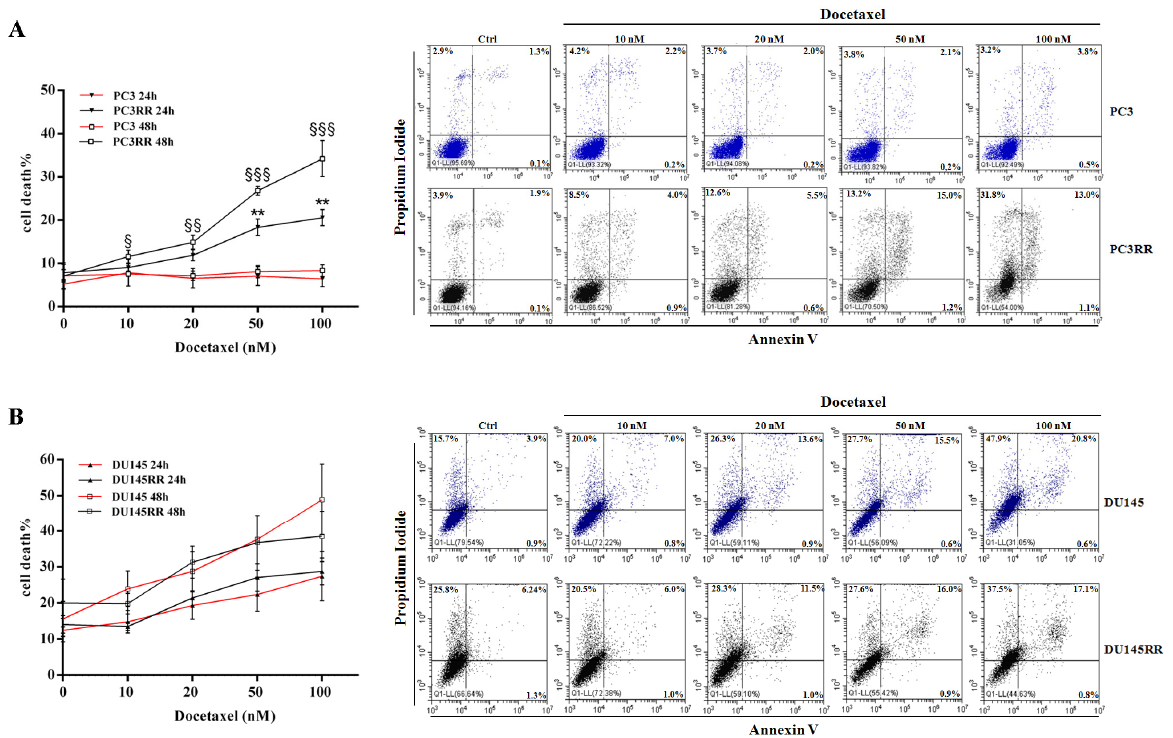
Figure 11. Effect of Docetaxel treatment on the viability of PC3/PC3RR cells and DU-145/DU-145RR cells.( A ) Representative dot plot of flow cytometry analysis for Annexin-V/Propidium Iodide staining in PC3/PC3RR (( A ), right) and DU-145/DU-145RR cells (( B ), right) to evaluate percentage of dead cells after treatment with different concentrations of Docetaxel at 48 h. For each dot plot, necrotic cells are localised in the upper left panel, whereas late and early apoptotic cells are in the upper and down right panels, respectively. The graphs show the percentage of cell death at 24 and 48 h after various doses of Docetaxel for PC3/PC3RR (( A ), left) and DU-145/DU-145RR cells (( B ), left).Data represent the mean of cell death percentage ± S.E.M. derived from at least three independent